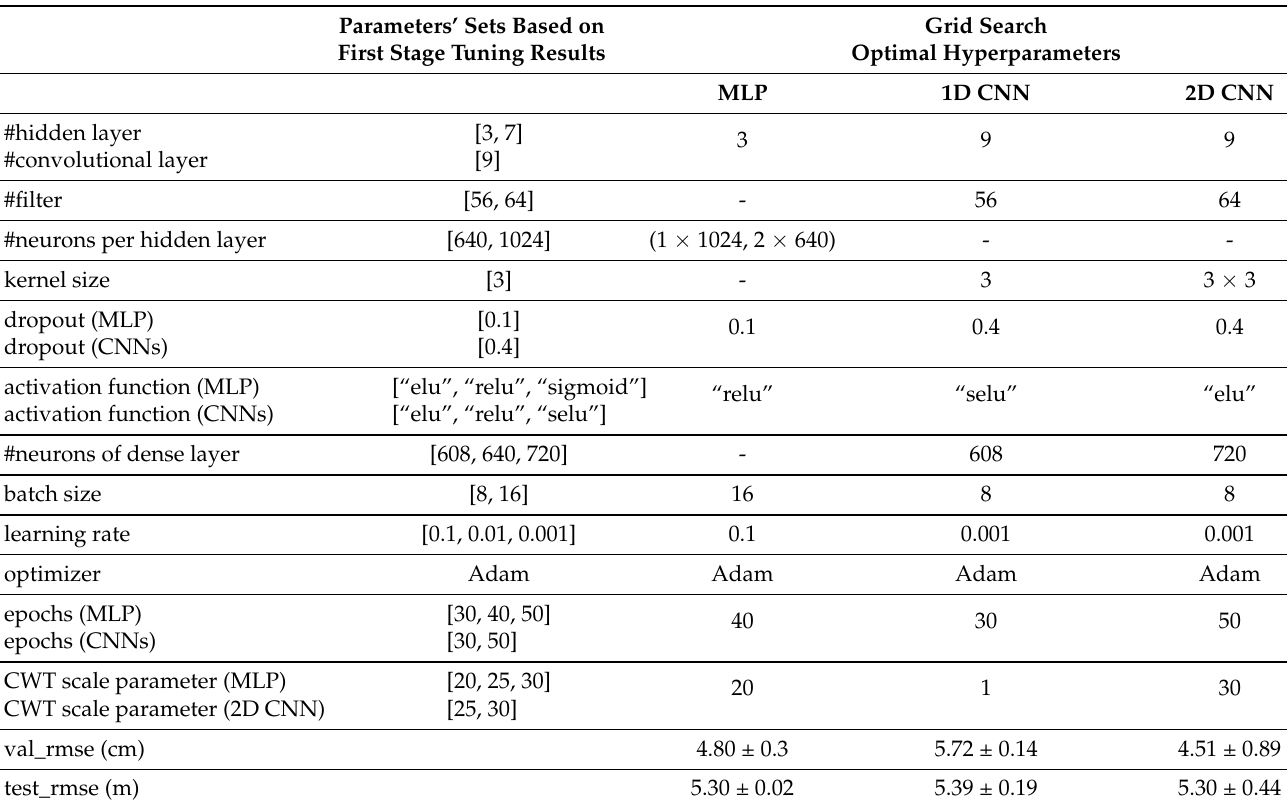
Table 4. MLP, 1D CNN, and 2D CNN second stage Grid Search results. Parameters’ Sets Based on